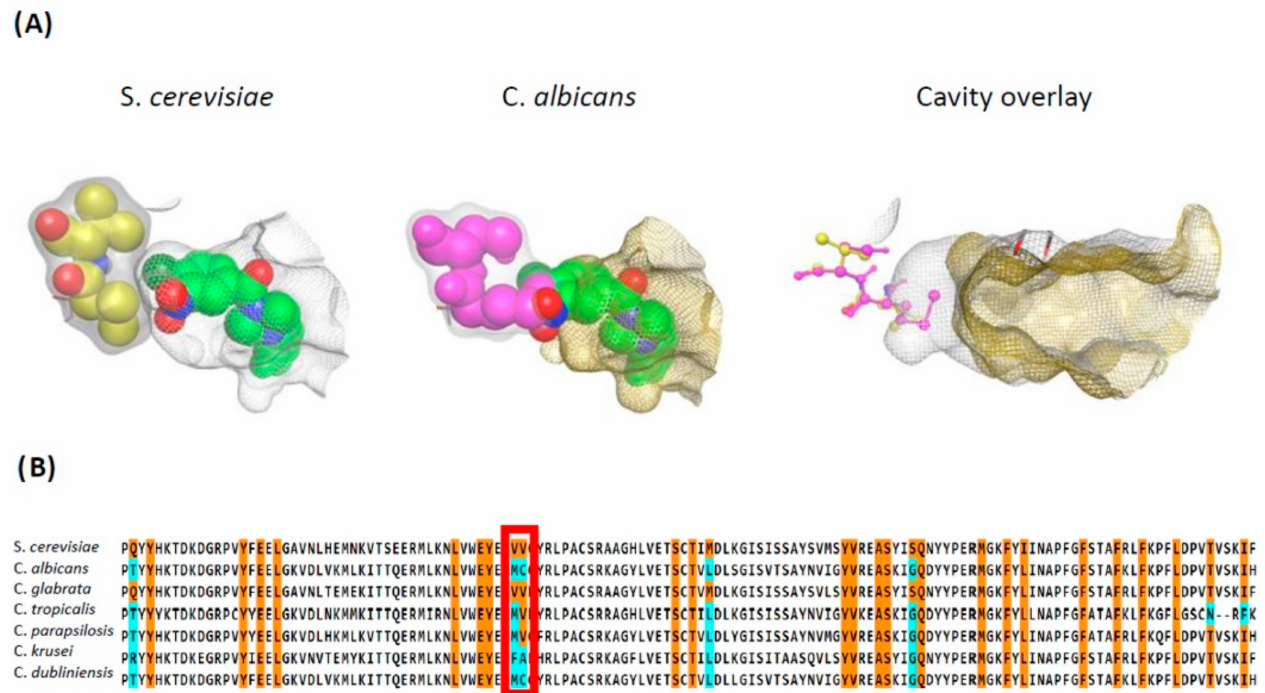
Figure 9. VV-Motif and Sec14 resistance/sensitivity to validated small molecule inhibitors. ( A ) The VV-motif and poly- morphisms and the associated structural differences are highlighted in comparison of the NPPM binding space within the lipid binding pockets of S. cerevisiae and C. albicans Sec14 PITPs. Left panel: The S. cerevisiae binding pocket is shown with the dock pose of bound NPPM illustrated in green space fill render. The VV-motif is highlighted in yellow space fill representation, and the lipid binding pocket surface is rendered as transparent grey mesh. Center panel: The C. albicans binding pocket is shown with a dock pose of NPPM rendered in green space fill, and the lipid binding pocket surface is rendered as transparent gold mesh. The C. albicans binding VV-motif cognate is diverged (MC), and this MC-motif is shown in magenta space fill representation. The steric clash between the MC-motif and the NPPM binding space is apparent. Right panel: The VV-motif regions of the S. cerevisiae and C. albicans Sec14 lipid binding pocket are compared. The S. cerevisiae VV-motif (yellow ball&stick) and the cognate C. albicans MC-motif (magenta ball&stick) residues are highlighted, and the lipid binding pocket surfaces of S. cerevisiae (grey) and C. albicans (gold) are rendered in transparent mesh. Note the C. albicans pocket space is contracted relative to that of S. cerevisiae because of the VV–MC polymorphism and this contraction prohibits accommodation of the aryl halide warheads of NPPM and picolinamide-based Sec14 inhibitors. ( B ) Residues of the lipid binding domain regions that form the lipid binding cavities of Sec14 PITPs from S. cerevisiae and the indicated Candida species are aligned. Residues whose sidechains line the lipid binding pocket surface are highlighted in orange, and polymorphisms at those positions are identified in cyan. The VV-motif is highlighted by the red